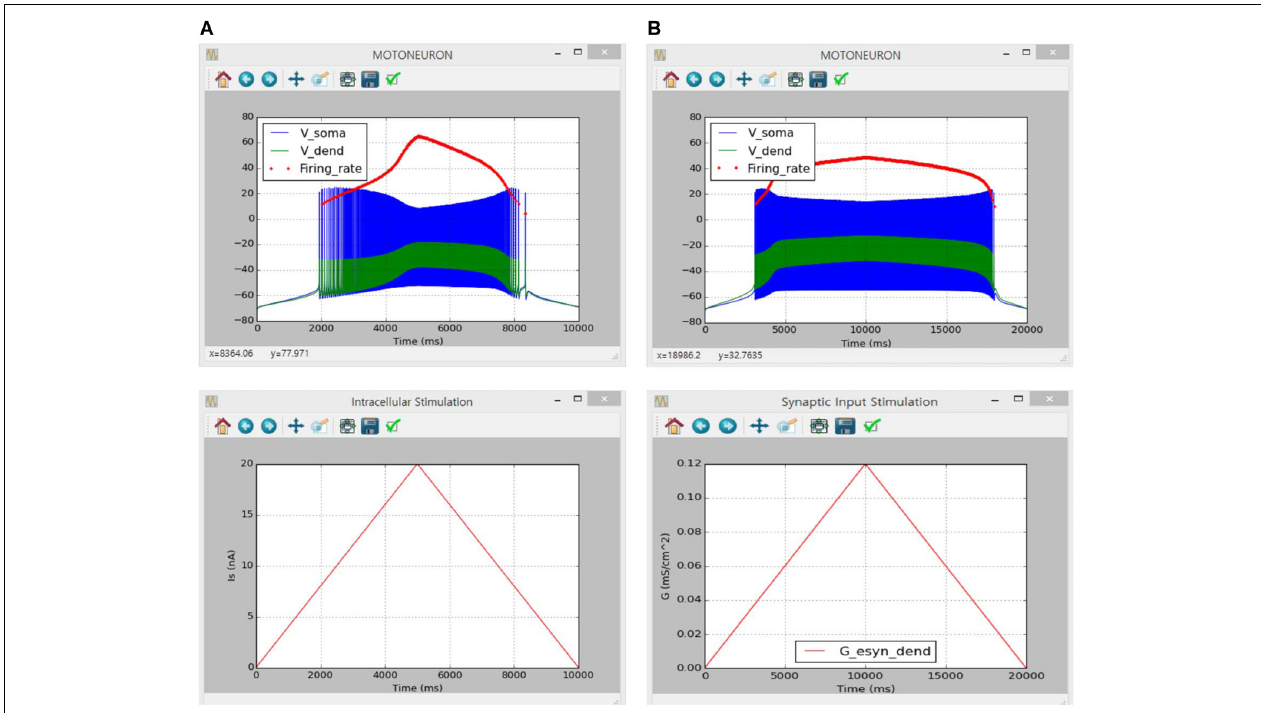
FIGURE 6 | Non-linear input–output behavior of a cat spinal motoneuron. (A) Instantaneous firing rate (Firing rate, upper panel) and voltage responses at the soma (V soma , upper panel) and the dendrite (V dend , upper panel) against slowly ascending and descending current injected into the soma (I S , bottom panel). (B) Instantaneous firing rate (Firing rate, upper panel) and voltage responses at the soma (V soma , upper panel) and the dendrite (V dend , upper panel) against slowly ascending and descending variation in excitatory synaptic conductance at the dendrite (G, bottom